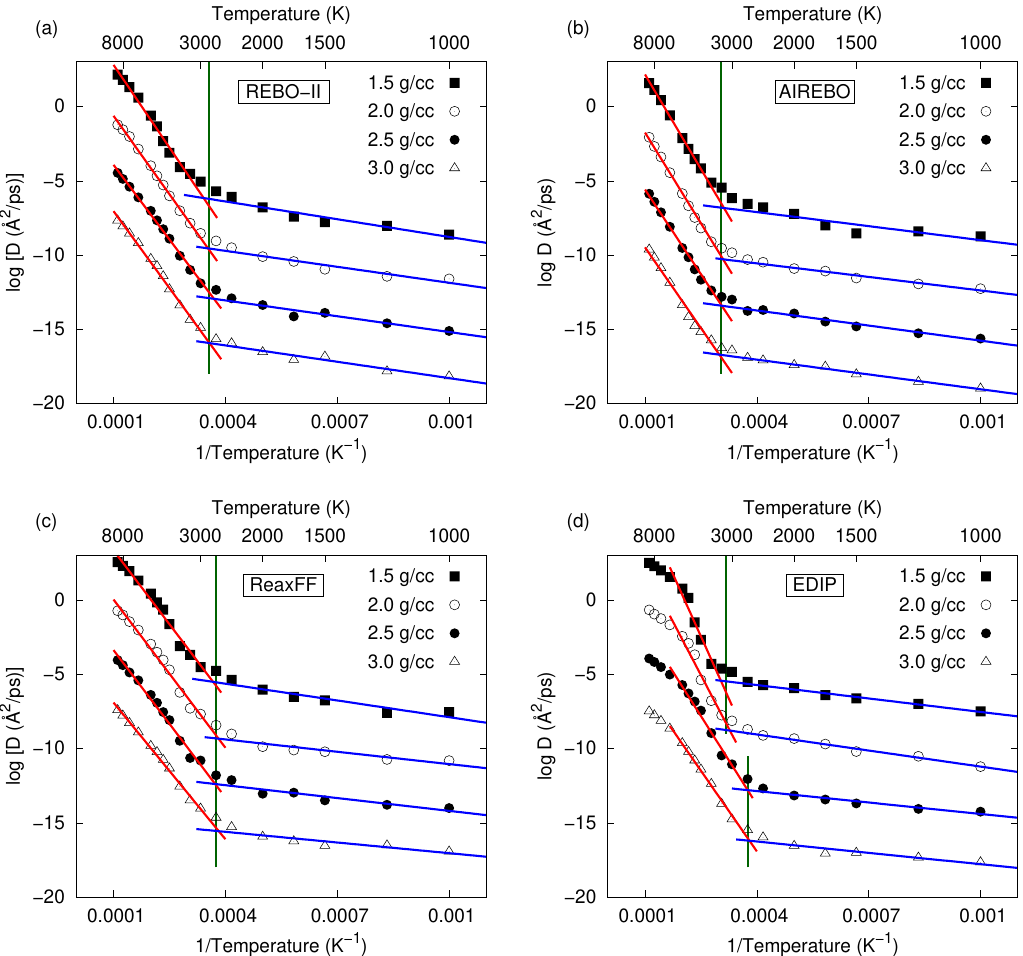
Figure 5. Arrhenius plot of the self-diffusion coefficient as a function of temperature for carbon structures of 1.5, 2.0, 2.5 and 3.0 g/cc using ( a ) REBO-II, ( b ) AIREBO, ( c ) ReaxFF and ( d ) EDIP potentials. As in Figure 4, data for the three higher densities is vertically shifted for